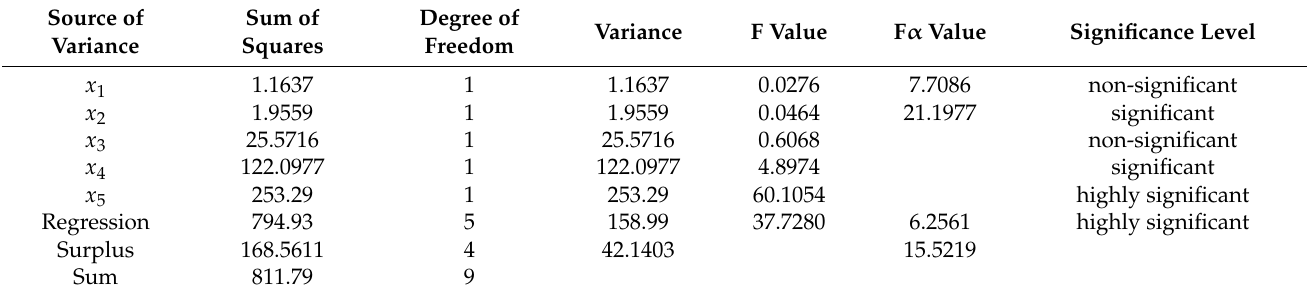
Table 4. Influence of various factors on residual film recovery index variance analysis